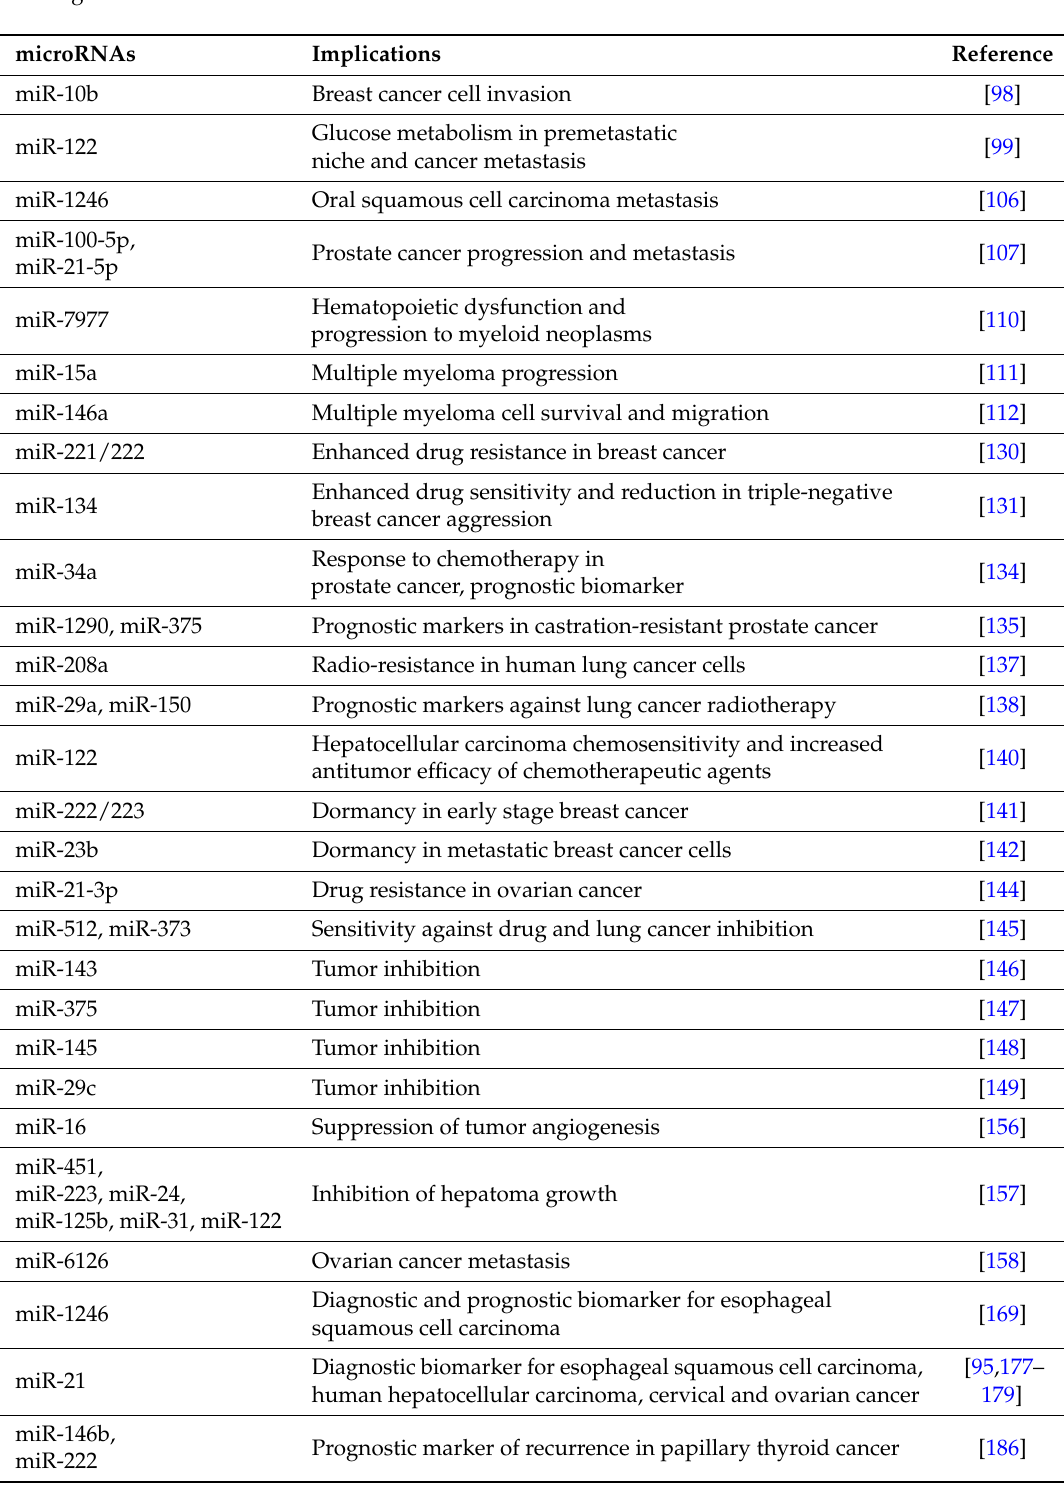
Table 2. Potential microRNAs in extracellular vesicles implicated in tumor progression and drug